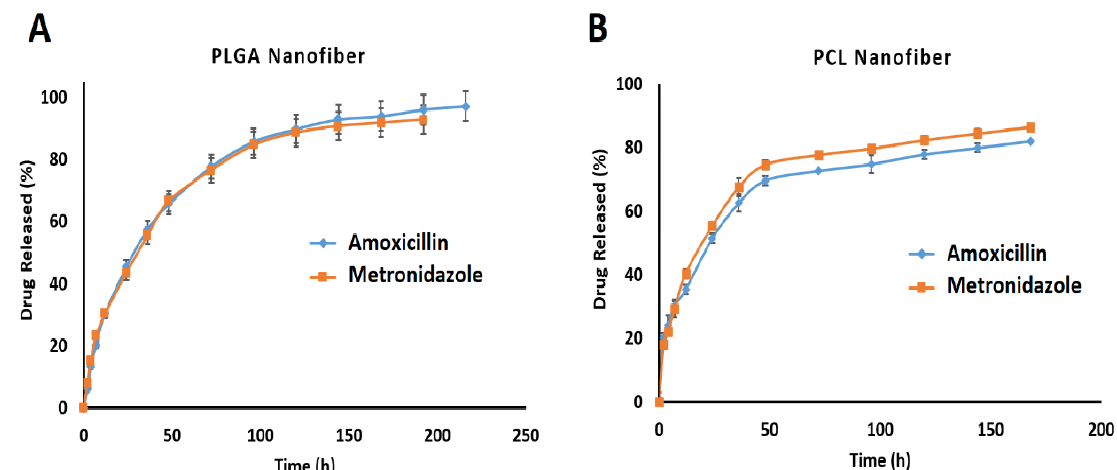
Figure 4. The percentage of cumulative drugs released from ( A ) PLGA nanofibers and ( B ) PCL nanofibers in phosphate buffer (pH = 7.4) at 37 °C in vitro measured by HPLC.